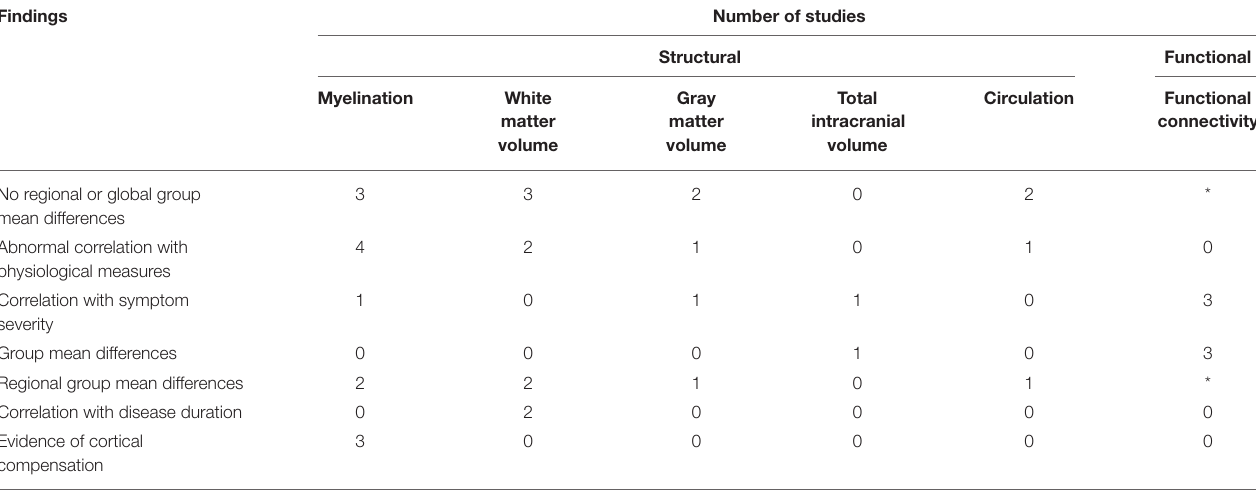
Structural Functional Circulation Functional Total Gray Myelination White connectivity intracranial matter matter volume volume volume